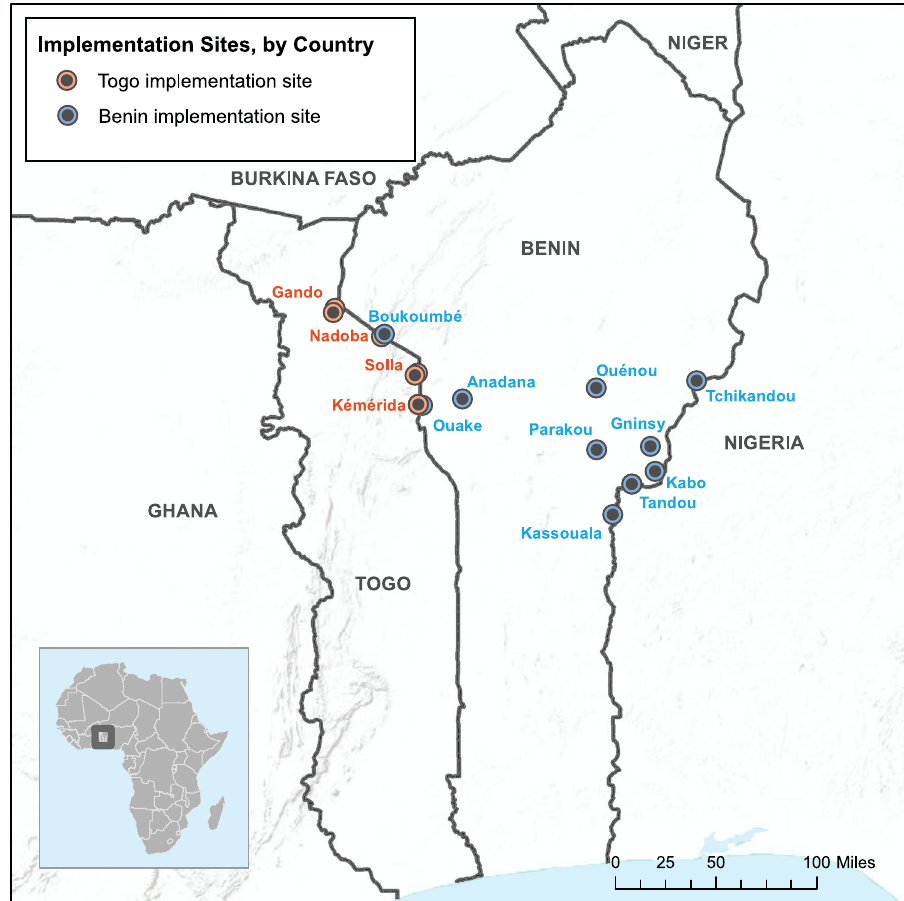
Fig. 4 Round 2 Population Connectivity Across Borders (PopCAB) implementation sites in Togo and Benin, April 2018. The binational map of Togo and Benin highlights the 14 cities where the fi eld teams implemented PopCAB events.